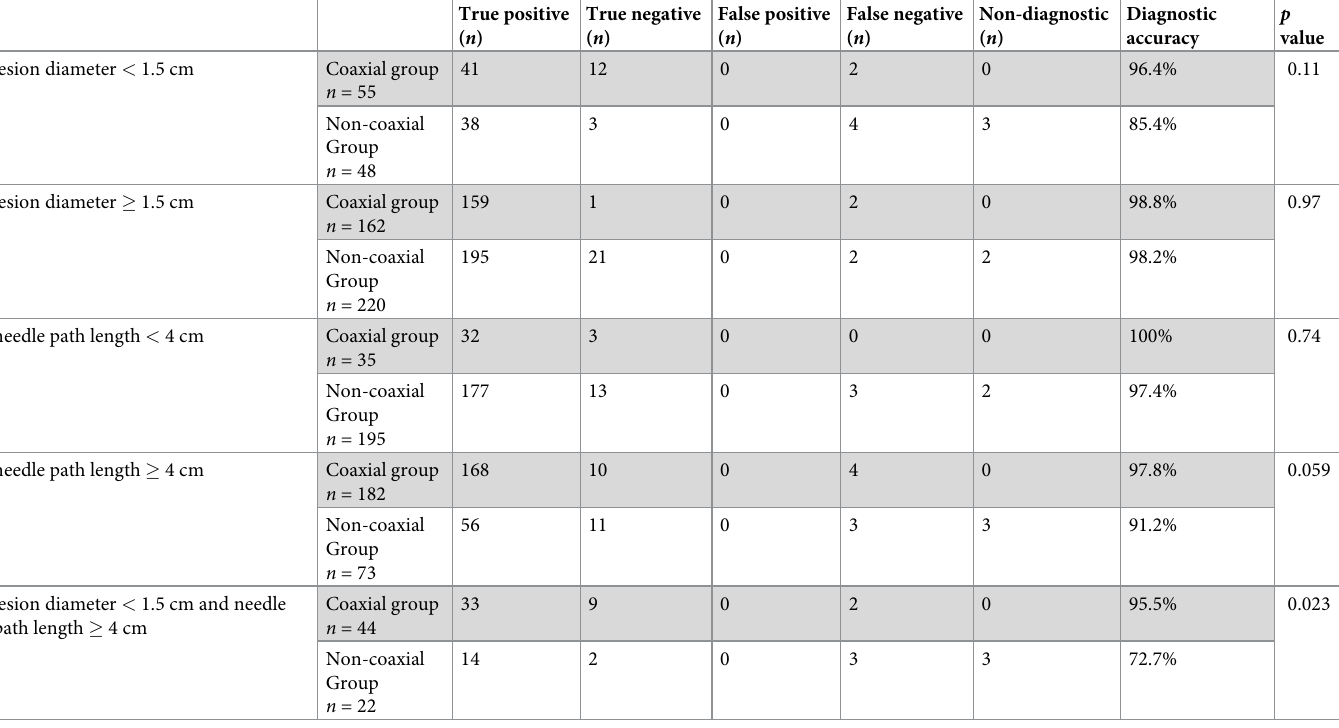
Table 4. The diagnostic yields in different subgroups.